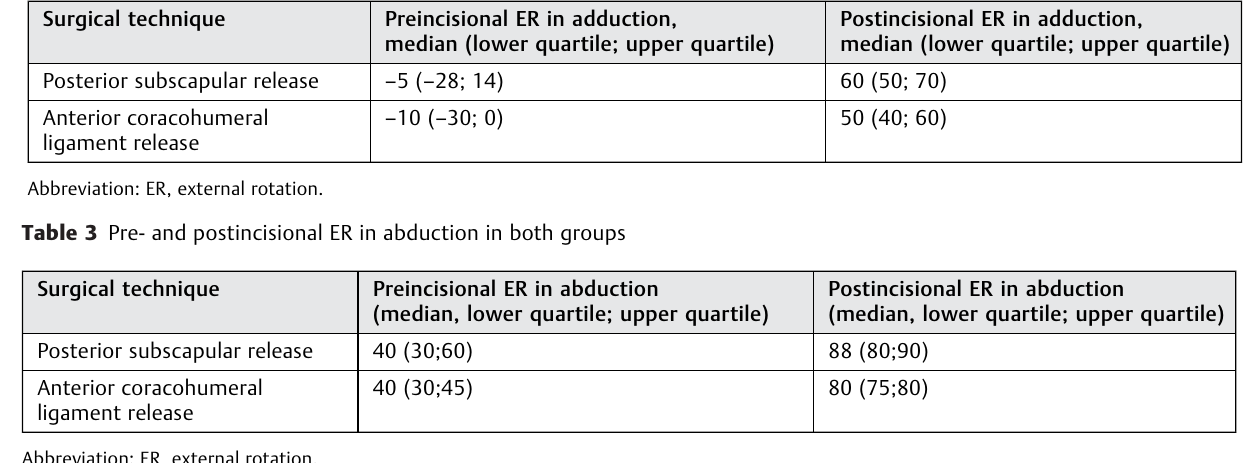
Table 2 Pre- and postincisional ER in adduction in both groups Surgical technique